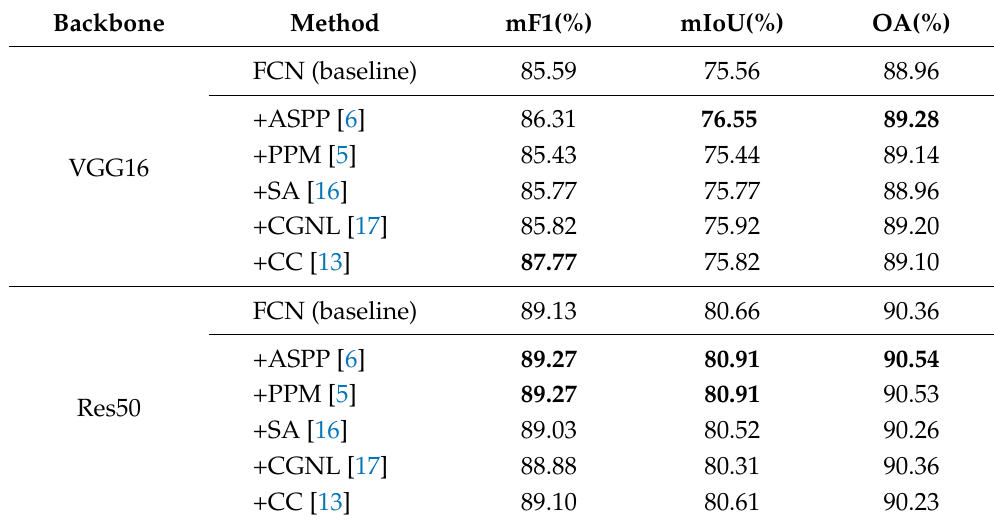
Table 4. Comparison with different context aggregation modules in vaihingen